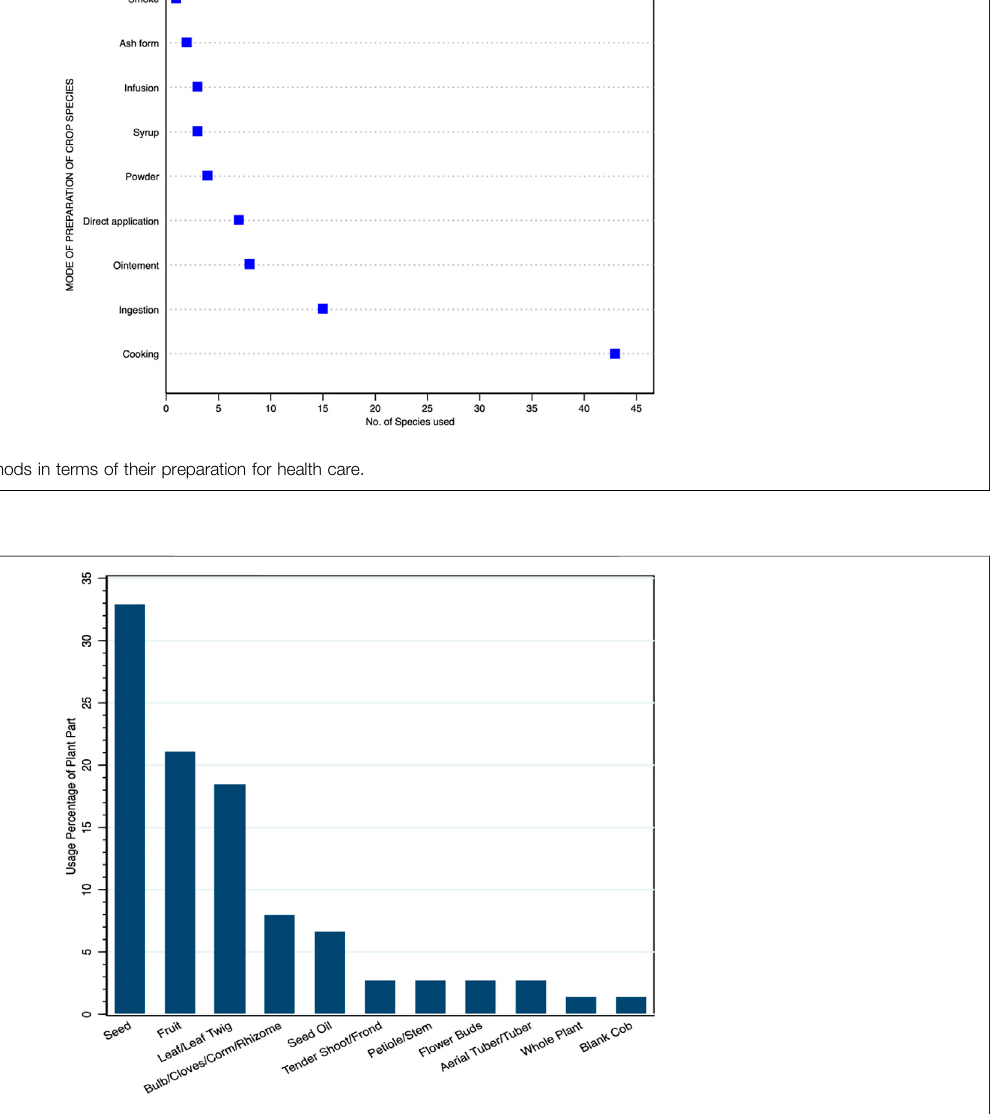
FIGURE 4 | Plant part used in preparation of